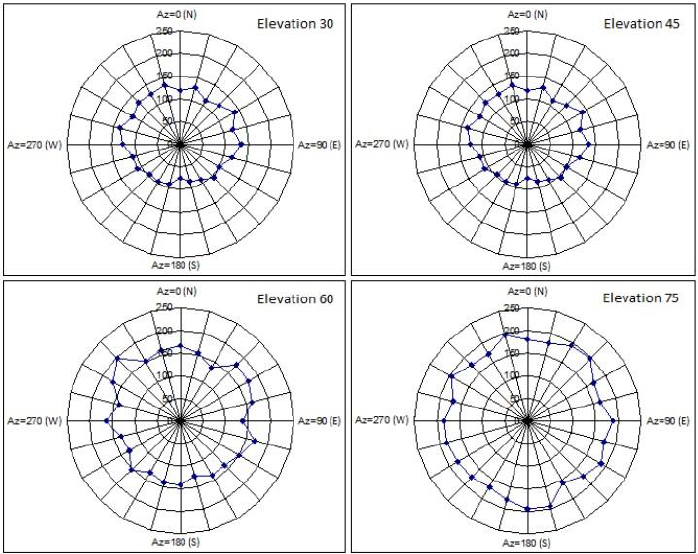
Figure 7. Estimated number of targets trackable in CW mode at varying elevation angles [19].